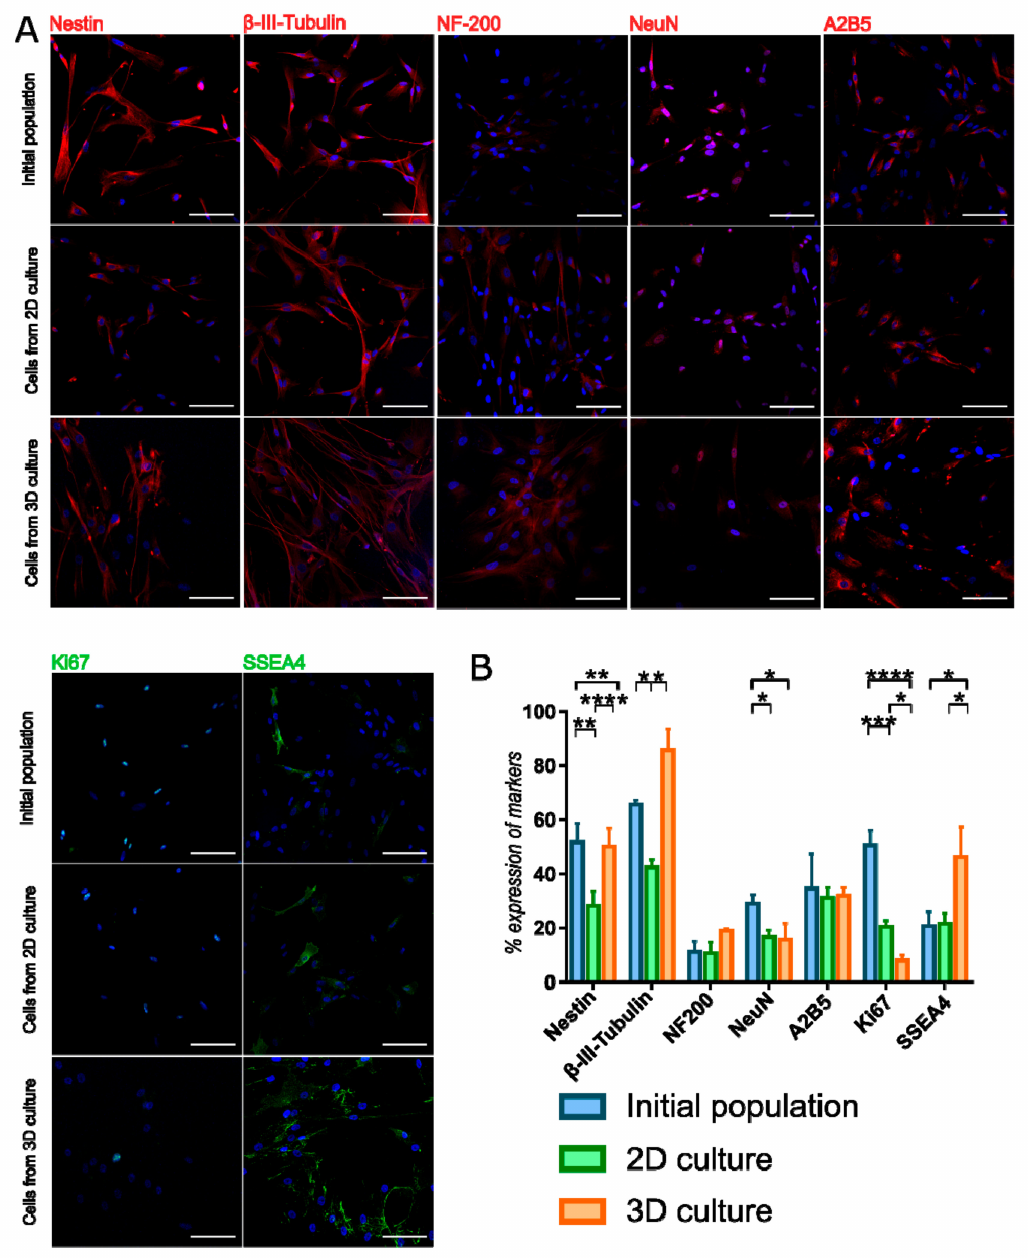
Figure 5. Immunocytochemistry staining of neural and pluripotent markers in WJ-MSC cultured in different conditions. ( A ) 3D cultures changes the expression of some neural and pluripotent markers what is observed even after reseeding to 2D culture. Scale bars: 100 µ m. ( B ) Analysis of marker expression in WJ-MSC populations. Following populations of WJ-MSC were used: cells from 3rd passage (initial populations), cells from 7th passage (2D culture) and cells cultured as spheroids after reseeding to 2D (3D culture). The results are presented as mean values of 3 experiments ± SD. For * < 0.05, ** <0.01, *** < 0.001, **** <